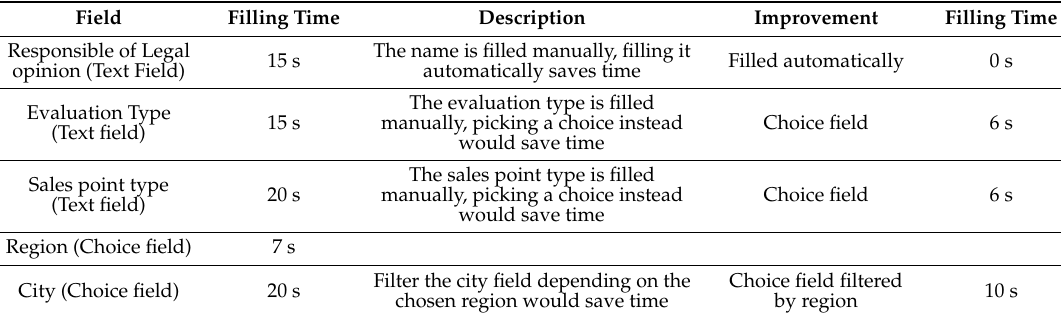
Table 4. Interface fields descriptions and Table 4 Interface fields descriptions and improvements.